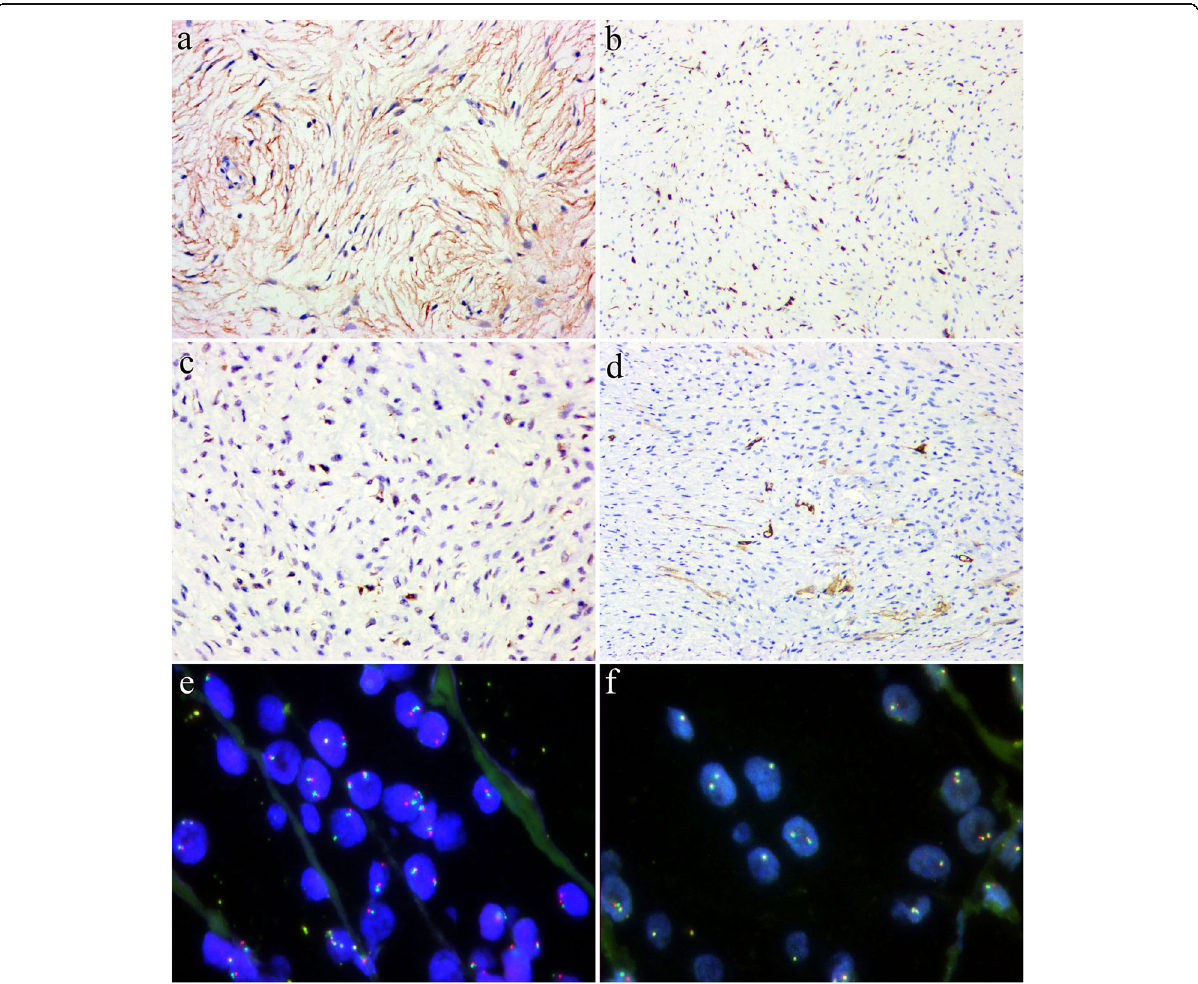
Fig. 3 Immunohistochemically, the tumor cells showed diffuse and faint EMA positivity ( A ) and focally positive staining for MUC4 ( B ), claudin-1 ( C ), and CD34 ( D ). FISH analysis revealed that the tumor cells were negative for MDM2 amplification ( E , red signals: MDM2; green signals: CEP12 ) and FUS rearrangement ( F , red signals: 5 ’ FUS; green signals: 3 ’ FUS )